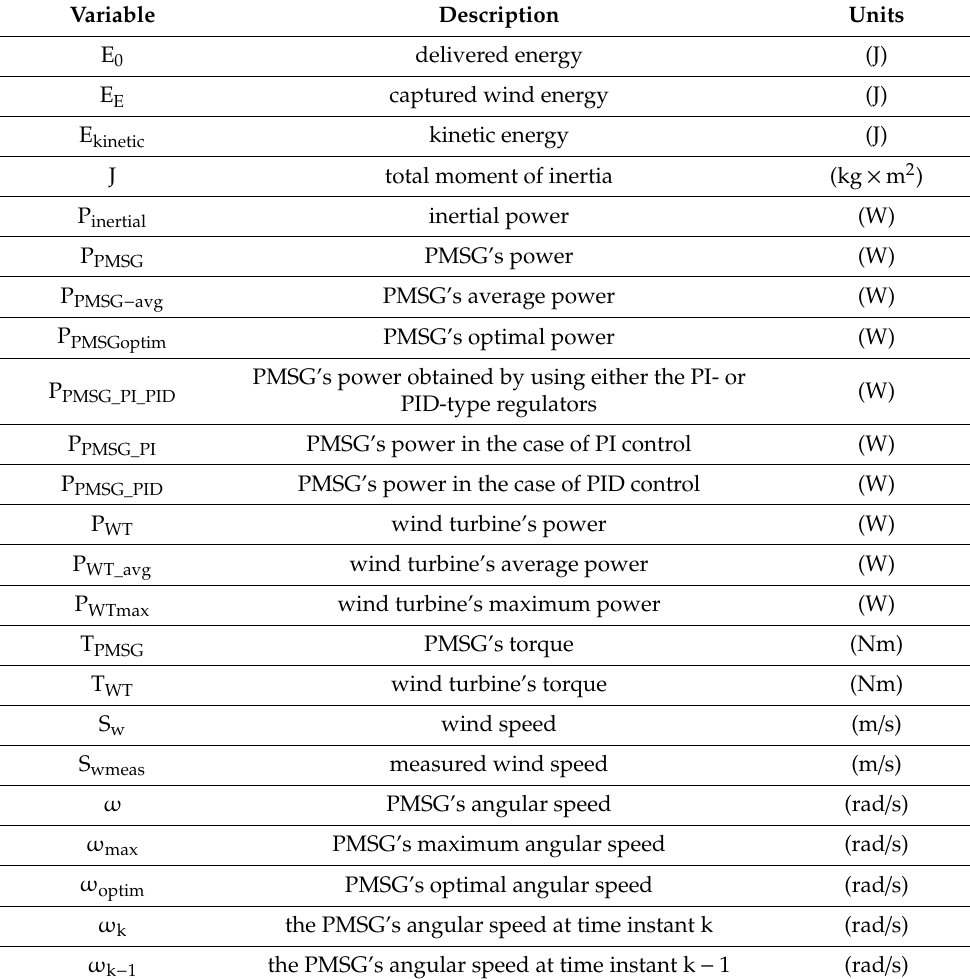
Table A2. List of the variables used in the